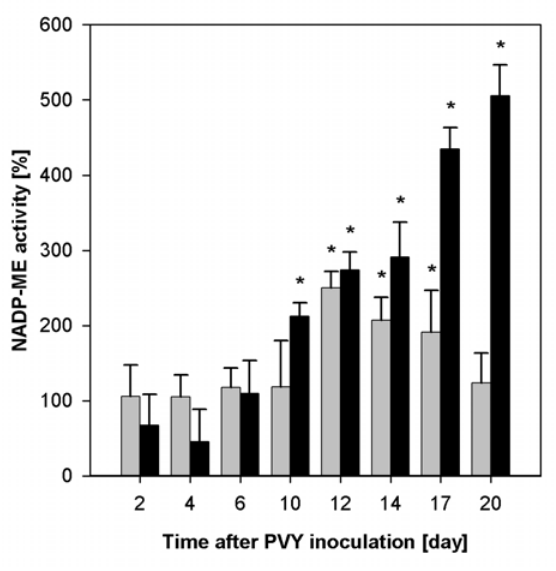
Figure 2. Activities of NADP-ME from Nicotiana tabacum L. leaves during PVY O (grey columns) and PVY NTN (black columns) infections calculated per fresh mass. The activity of each sample is shown as percentage of the non-infected control in particular day, where leaves (not shown) was the same as in non-inoculated